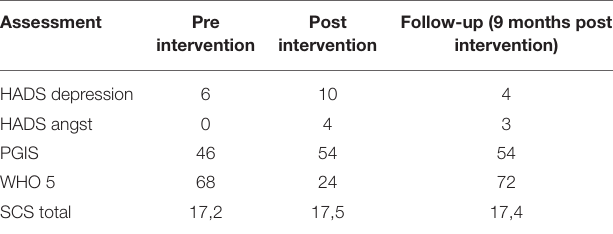
TABLE 3 | Pre-, post- and follow-up scores on assessment tests. Assessment